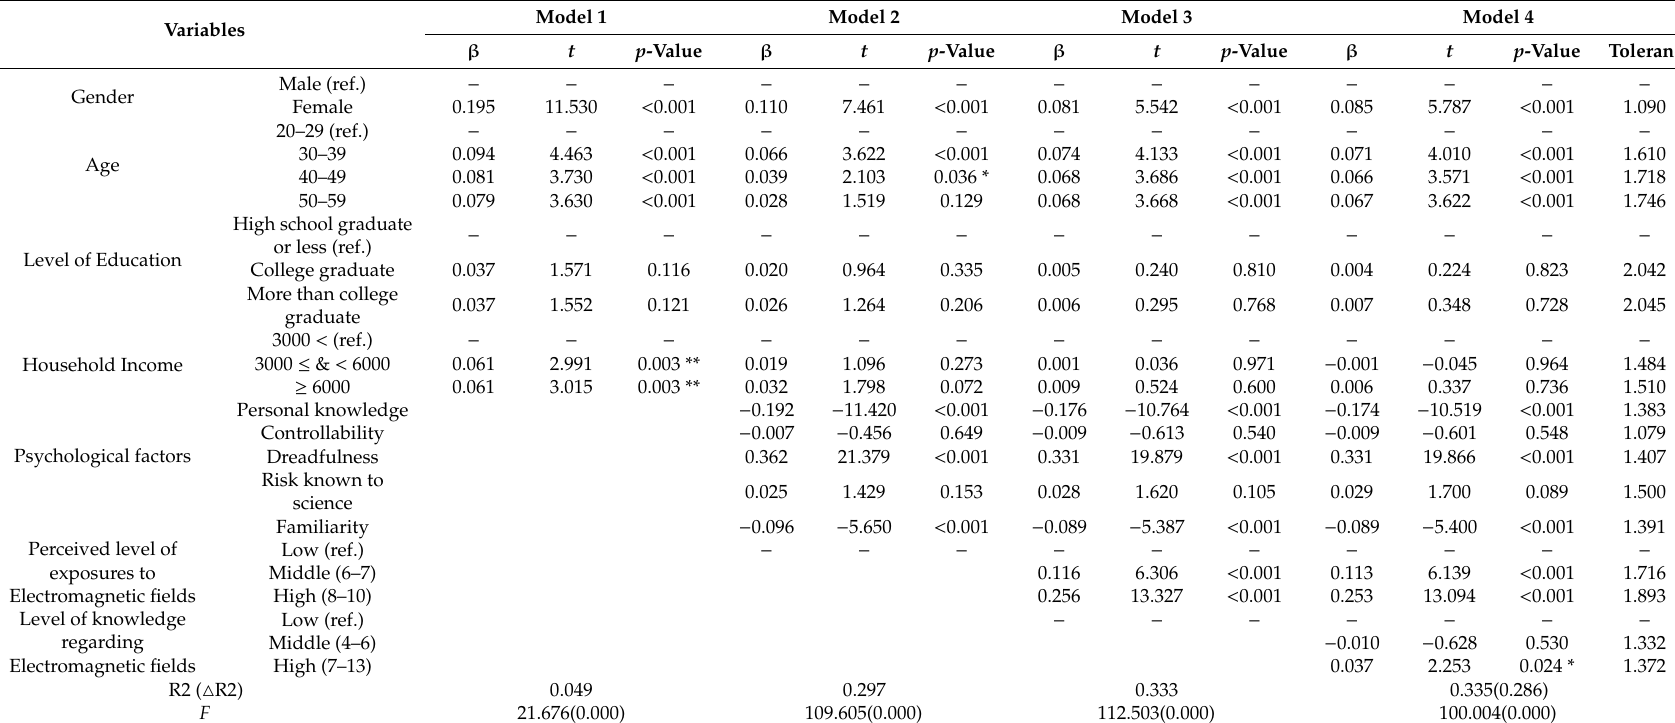
Table 2. Result of hierarchical multiple regression analysis of risk perceptions of cell